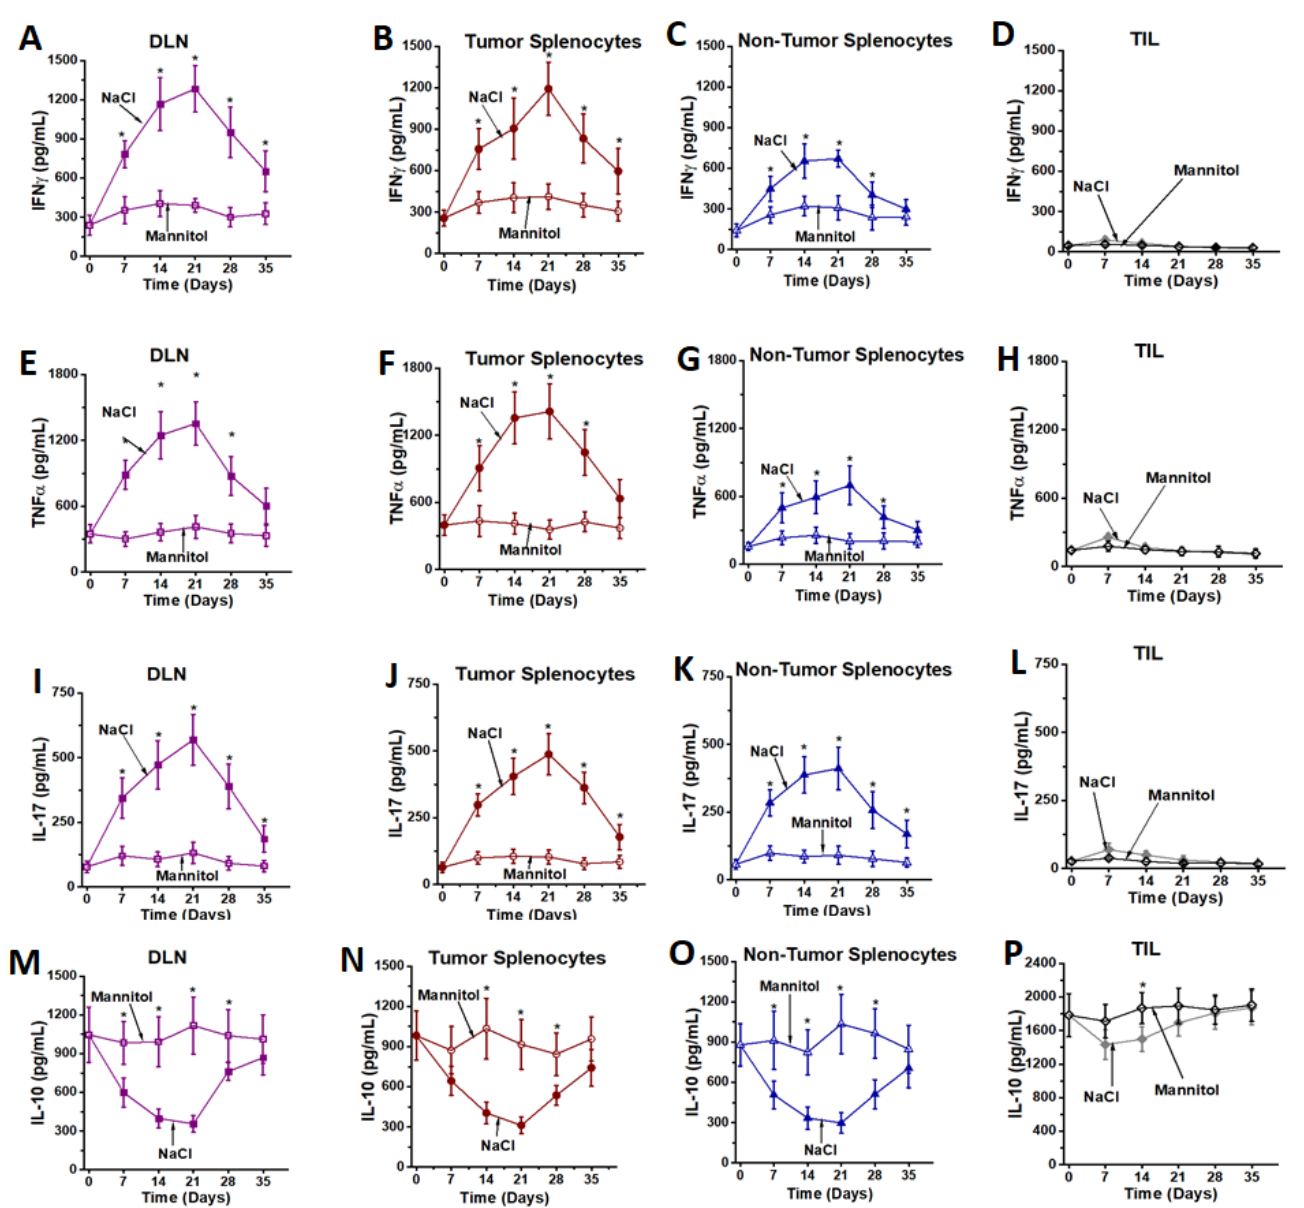
Figure 4. Cytokine expression from ex vivo expanded CD4+T cells. Inflammatory cytokines—IFN γ ( A – D ), TNF α ( E – H ) and IL-17 ( I – L ); and immunosuppressive cytokine, IL-10 ( M – P ) were analyzed in CD4+T cells obtained from DLNs ( A , E , I , M ), tumor splenocytes ( B , F , J , N ), non-tumor splenocytes ( C , G , K , O ) and TILs ( D , H , L , P ) following treatment with high salt (filled symbols) and equimolar mannitol (open symbols). Data obtained from 5 independent measurements and presented as mean ± SEM; (*) p < 0.05.